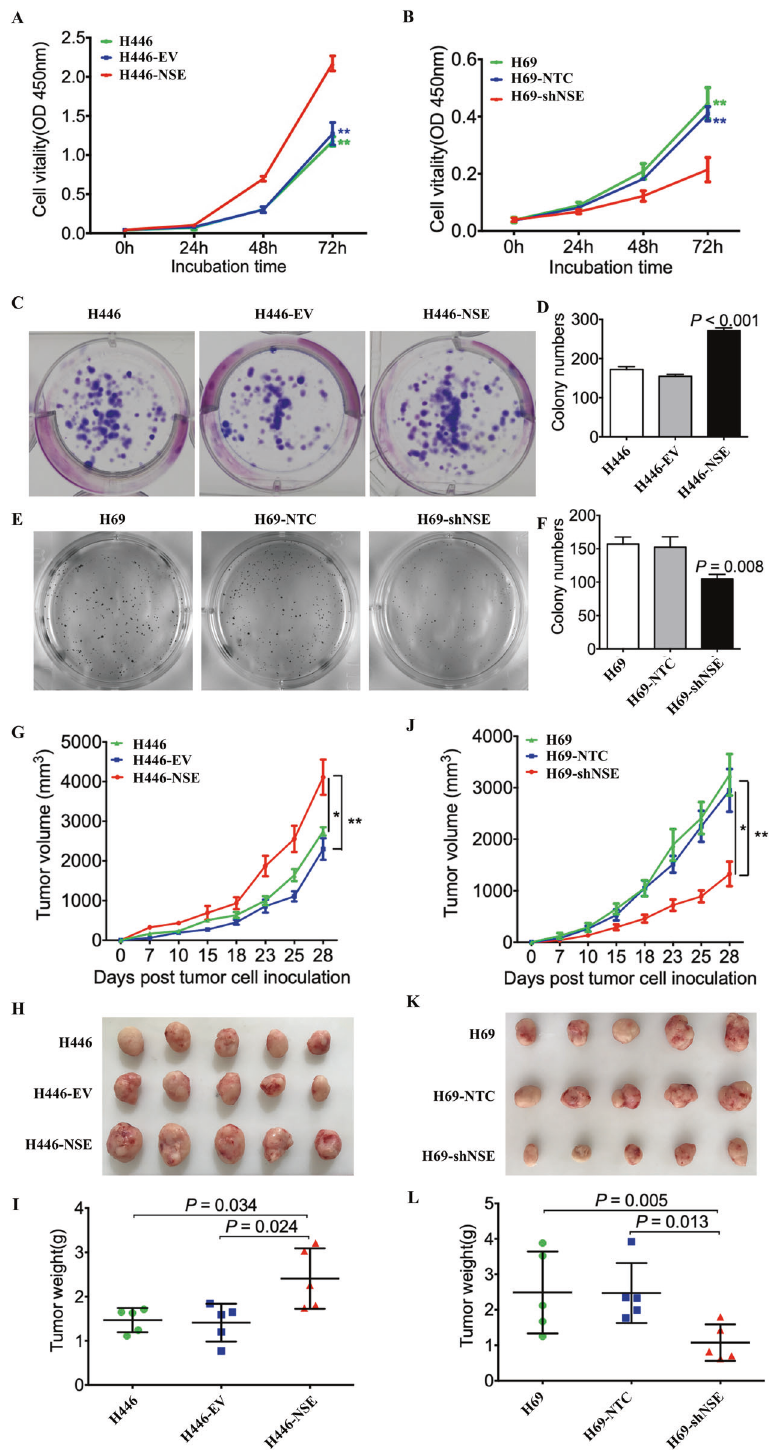
Fig. 2 NSE promotes SCLC tumor growth in vitro and in vivo. The cell proliferation capability was assessed using the CCK8 assay. A Overexpression of NSE promoted the cell proliferation capability of H446 cells. B Knockdown of NSE repressed cell proliferation of H69 cells. C NSE overexpression promoted the colony-formation capability of SCLC cells. D Colonies were stained with crystal violet, and the number of colonies was counted and shown in a column diagram. Error bars represent the mean ± SD of three independent experiments. E Silencing of NSE inhibited the colony-formation capability of SCLC cells. F The number of colonies was counted and is shown in a column diagram. Error bars represent mean ± SD from three independent experiments. G – I Overexpression of NSE promotes tumor growth in vivo. G The tumor growth curves were compared between NSE overexpression cells, empty vector cells, and untransduced cells. H The images showed the macroscopic appearance of tumors resected from NSE overexpression or control tumors. I The image showed the statistical analyses of the tumor weights. J – L Silencing NSE inhibited the tumor-initiating capability of SCLC cells. J The tumor growth curves are shown. K The images show the macroscopic appearance of tumors resected from NSE silencing cells or negative control tumors. L The image shows the statistical analyses of the tumor weights. Data are represented as mean ± SD for three experiments. * P < 0.05; ** P <